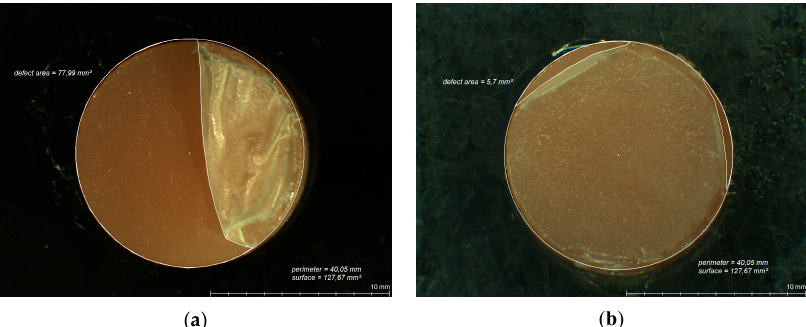
Figure 5. Light microscopic analysis of remaining CS on PET specimens after 30,000 cycles of abrasion by simulated tooth brushing (( a ) taken from test series I; ( b ) taken from test series VI).